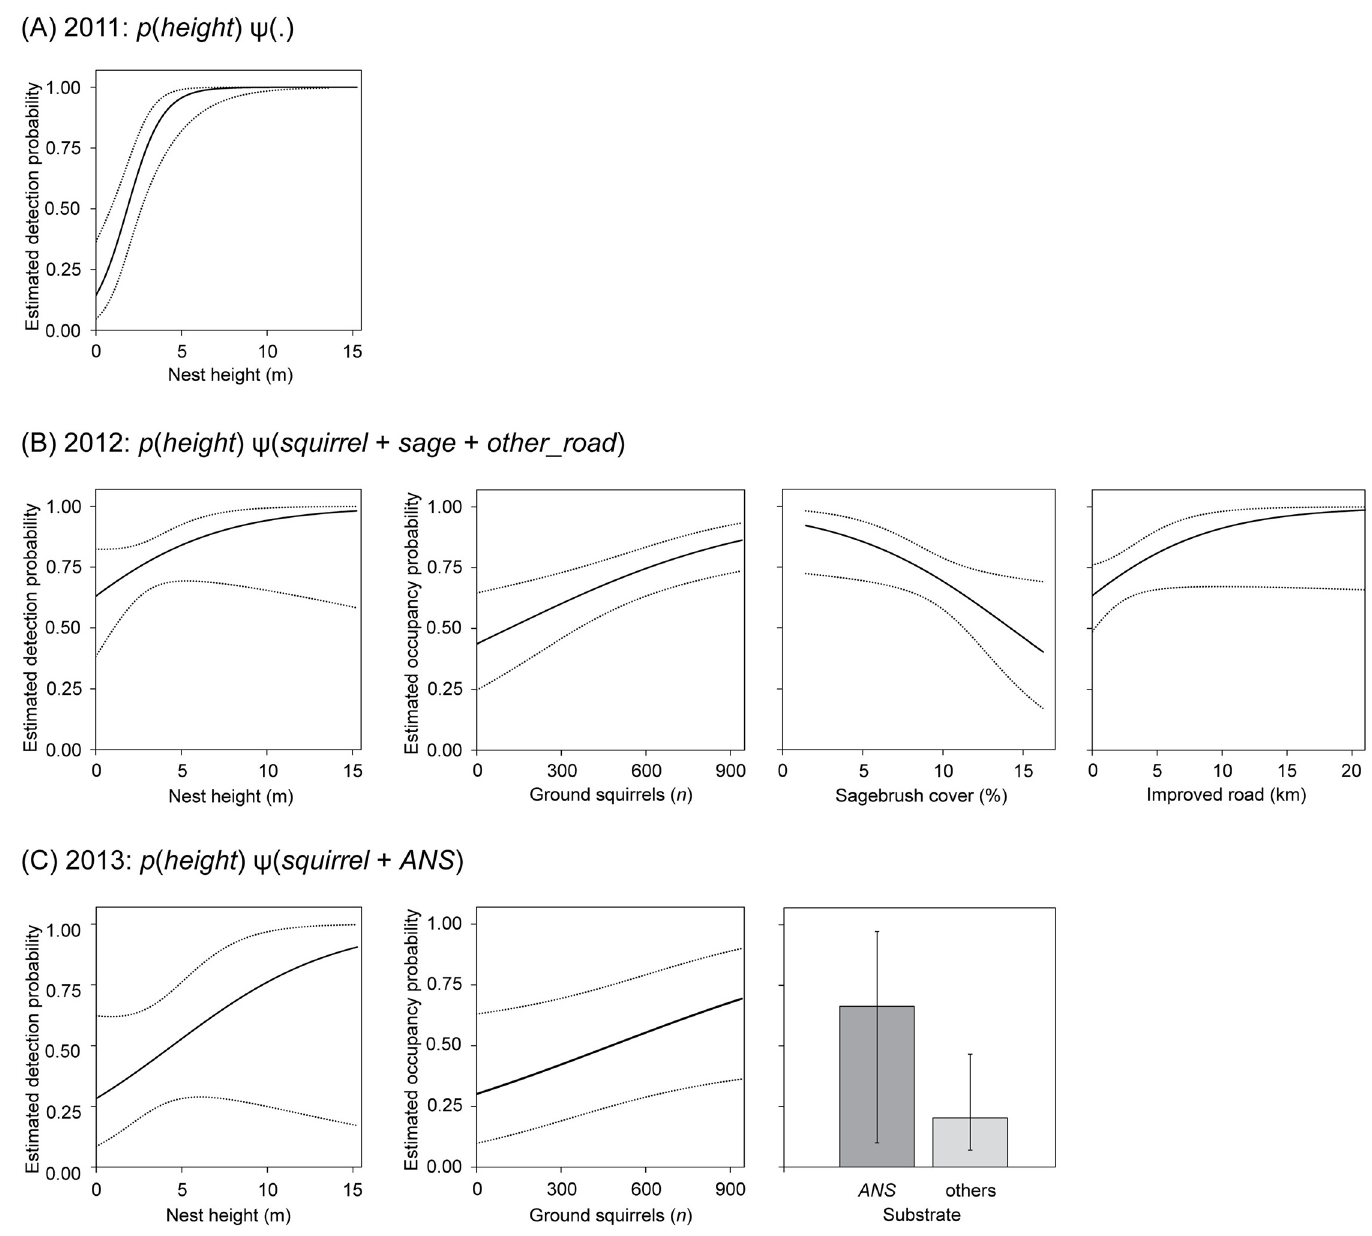
Fig 2. Relationships of covariates with detection and re-occupancy probabilities of ferruginous hawk territories in Wyoming, USA. Plots depict probabilities of detection ( p ) and re-occupancy ( ψ ) as functions of individual covariates from best-approximating single-season models with other covariates fixed at mean values during (A) 2011, (B) 2012, and (C) 2013. Numerical covariate relationships are illustrated as functions (black lines) with 95% CI (dotted lines), and categorical covariates as group means (bars) with 95% CI (error bars). Model selection results are presented in Table 1. Covariates are defined as follows. Subscripts indicate spatial extent of 500-m radius around central nest site; covariates without subscripts refer to the extent of putative territory (1.5-km radius), except height , which refers to the most recently used substrate. Covariates are defined as follows: height , height (m) of nest substrate; squirrel , abundance of ground squirrels ( Urocitellus spp.); sage , cover (%) of sagebrush ( Artemisia spp.); gas_road 500 , length (km) of roads associated with oil and gas fields; other_road , length (km) of other improved roads; ANS , categorical covariate representing artificial nest structures compared to all other